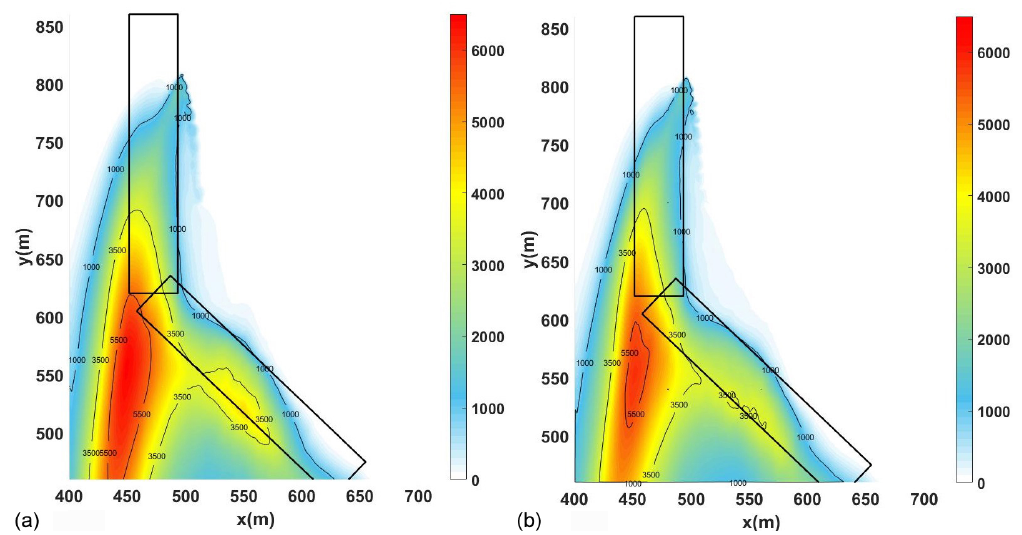
Figure 8. CO mean concentration ( µ g/m 3 ) at ground level, ( a ) results obtained with caffa3d, and ( b ) with the GPU-using version.